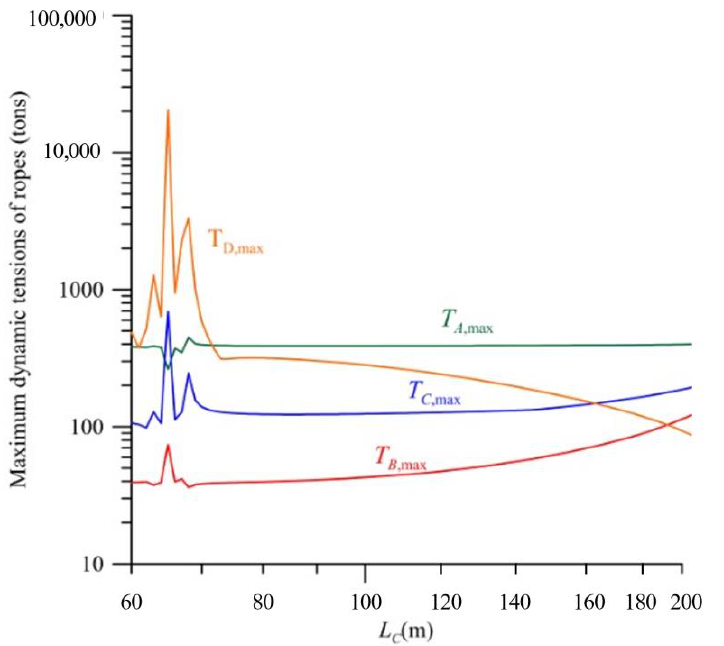
Figure 11. ( a ) Dynamic displacements of the four elements and ( b ) dynamic tensions of ropes under typhoon irregular wave for